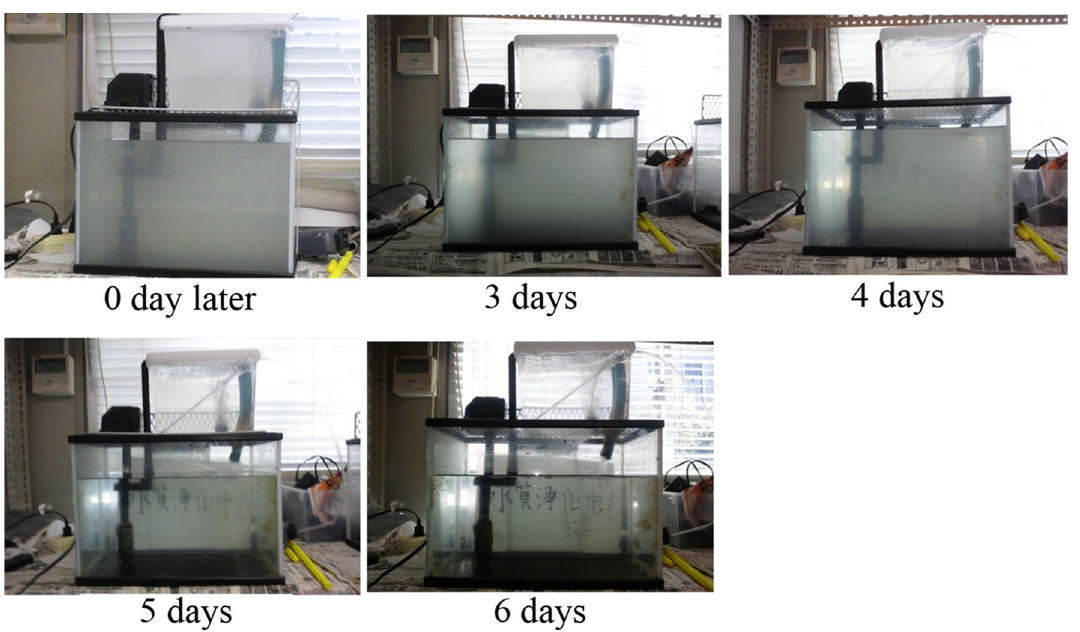
Fig. 3 Change of the transparency of the artificial waste water (15 L) containing 10 mL of milk and 15 mL of AS ‘‘without the PC’’